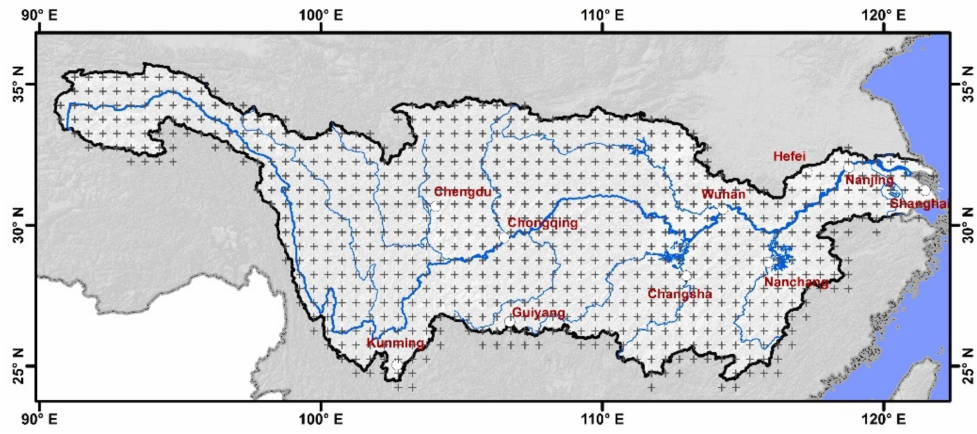
Figure 2. Grid points over the YRB in China’s Ground Precipitation (temperature) 0.5 ◦ × 0.5 ◦ Gridded